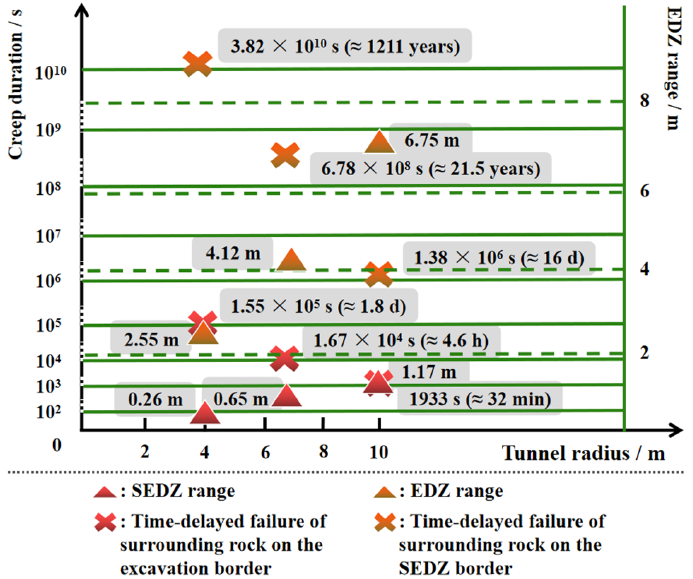
Figure 12. Time-delayed failure laws in the EDZ for the round tunnel cross section at the depth of 1900 m ( a = 4, 6.5 and 10 m).